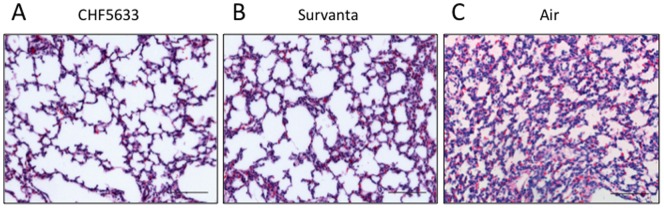
Lung Histology.Lung histology of peripheral area assessed after staining with hematoxylin and eosin. Both CHF5633 (A) and Survanta (B) groups showed various size alveoli with patchy atelectasis. The lung of the Air group (C) was atelectatic. Scale bar: 100 µm.